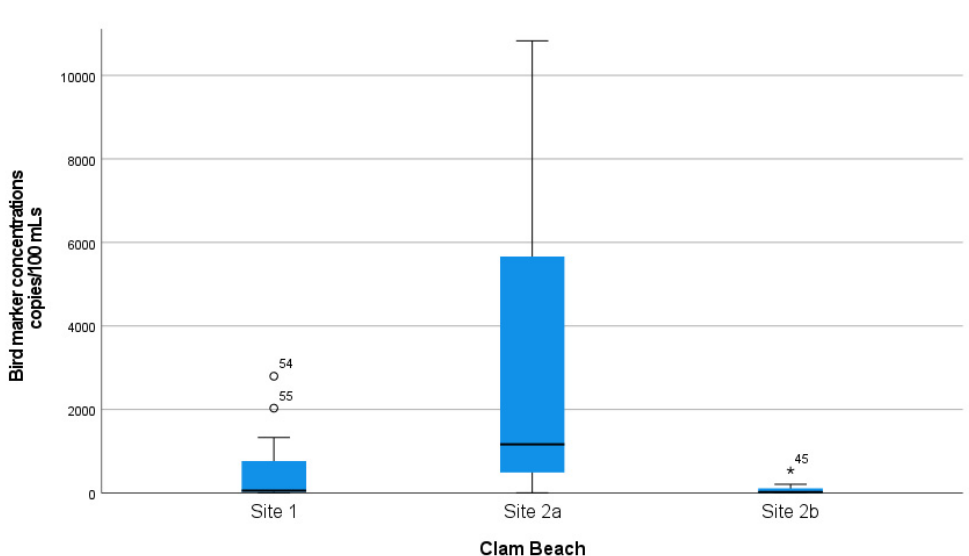
Figure 3. Distribution of bird marker concentrations at all three sampled locations. Mad River (site 1) was a reference site for comparison. Clam Beach near Strawberry Creek (site 2a) was in the mixing zone and considered an ocean sample. Clam Beach near Strawberry Creek (site 2b) was primarily in Strawberry Creek and considered a freshwater sample.